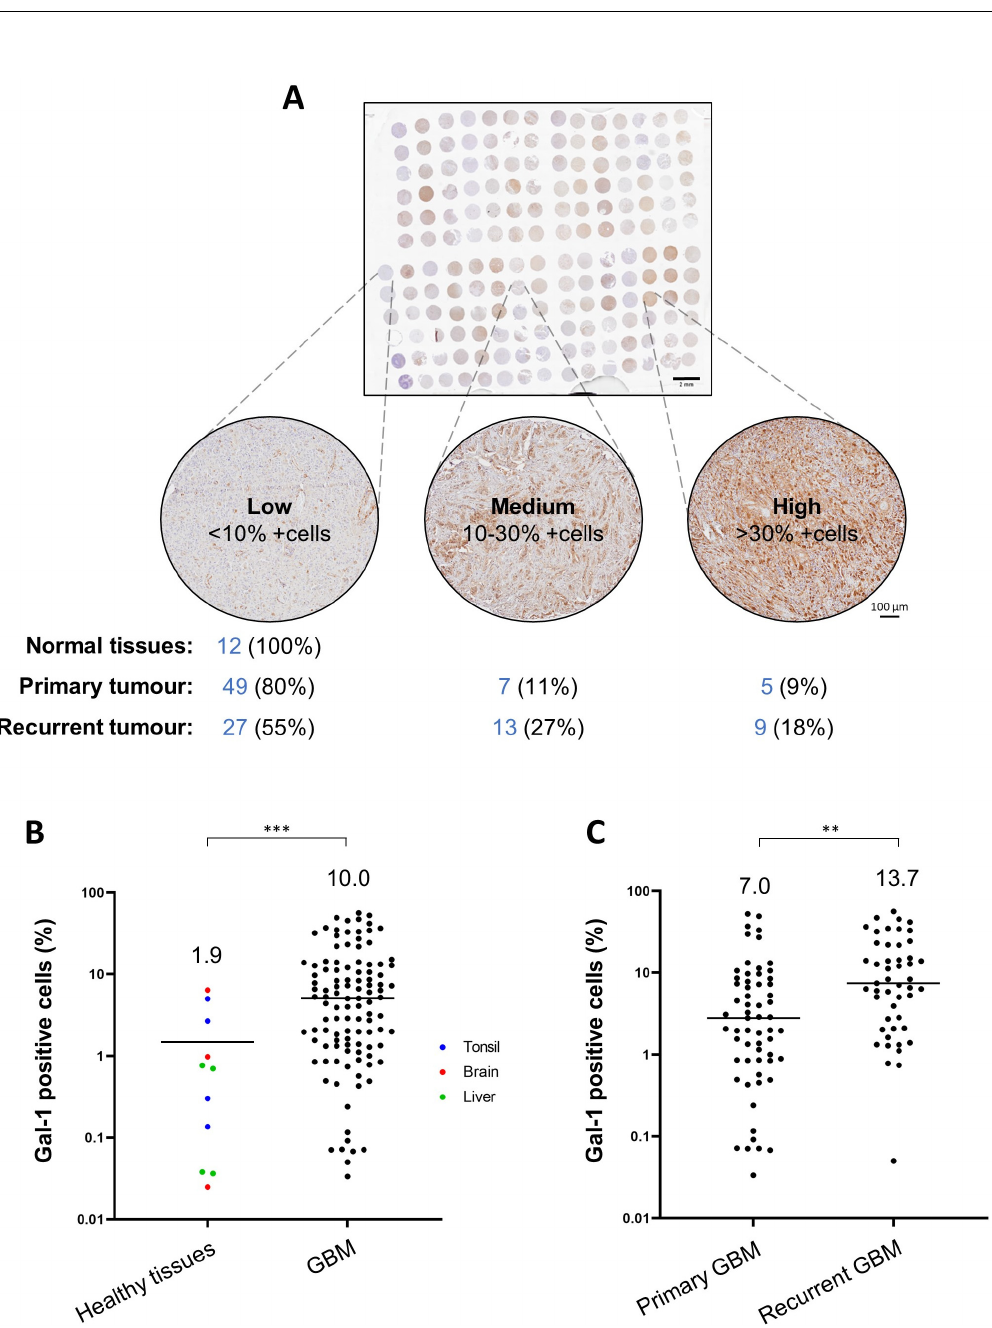
Figure 7. Differential expression of Gal-1 in normal tissues and in primary and recurrent GBM biopsies. ( A ) overview of the tissue microarray. This study included biopsies from normal tissue ( n = 12), primary GBM biopsies ( n = 61) and recurrent GBM biopsies ( n = 49). Biopsies were categorised based on Gal-1 expression after immunostaining with anti-galectin-1 antibody: low (<10% positive cells), medium (10–30% positive cells) or high expression (>30% positive cells). The number of biopsies in each category are indicated under each representative image. The staining was performed twice in each normal sample and thrice on tumour tissues. Quantification of Gal-1-positive cells (%) was performed as described in the Materials & Methods section using in-house software; ( B ) comparative analysis of Gal-1 expression between healthy tissues and GBM biopsies (primary and recurrent); ( C ) comparative analysis of Gal-1 expression between primary and recurrent GBM biopsies. The arithmetic mean of Gal-1-positive cells is indicated with a horizontal line and by the number above (** p ≤ 0.01; *** p ≤ 0.001).